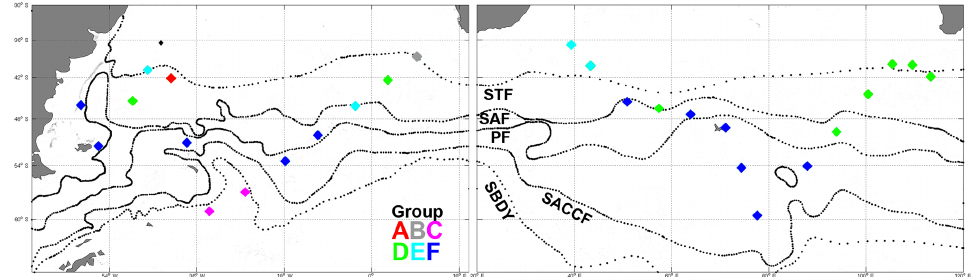
Figure 3. Statistically significant groups of coccolithophore and diatom communities in the Great Calcite Belt as identified by the SIMPROF routine. The colors designate which statistical group defines the coccolithophore and diatom assemblage at each station as shown in the group key. Fronts are defined as in Fig. 1. See Table 4 for full group species descriptions.